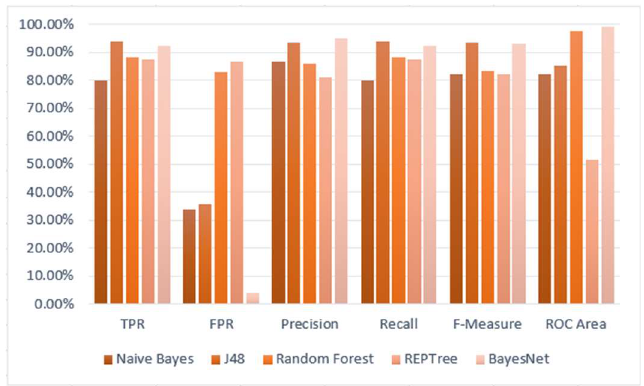
Figure 1 . Algorithms